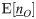
The expected number of open channels in the linearized mean-field CN (LCN) model predicts spark probability.(A) Expected number of open channels (E[N
O]) of the LCN model at t = 8 ms strongly correlated with p
S of the 3D spark model (R
2 = 0.934). Data shown for a collection of 15 clusters. (B) E[N
O] also correlated with λ
1 (red), but not with the number of channels in the cluster (n, black). Data points are from collection of 107 clusters. (C) Time dependence of the expected number of open channels for different initiating RyR2s (E[n¯O]) on edge of the cluster (blue), in the interior (red), and the average (E[N
O], black) for the cluster shown in the following panel. (D) Heatmaps of E[n¯O] (left) and p
S estimated using the 3D spark model (right) illustrates intra-cluster gradients in spark probability.